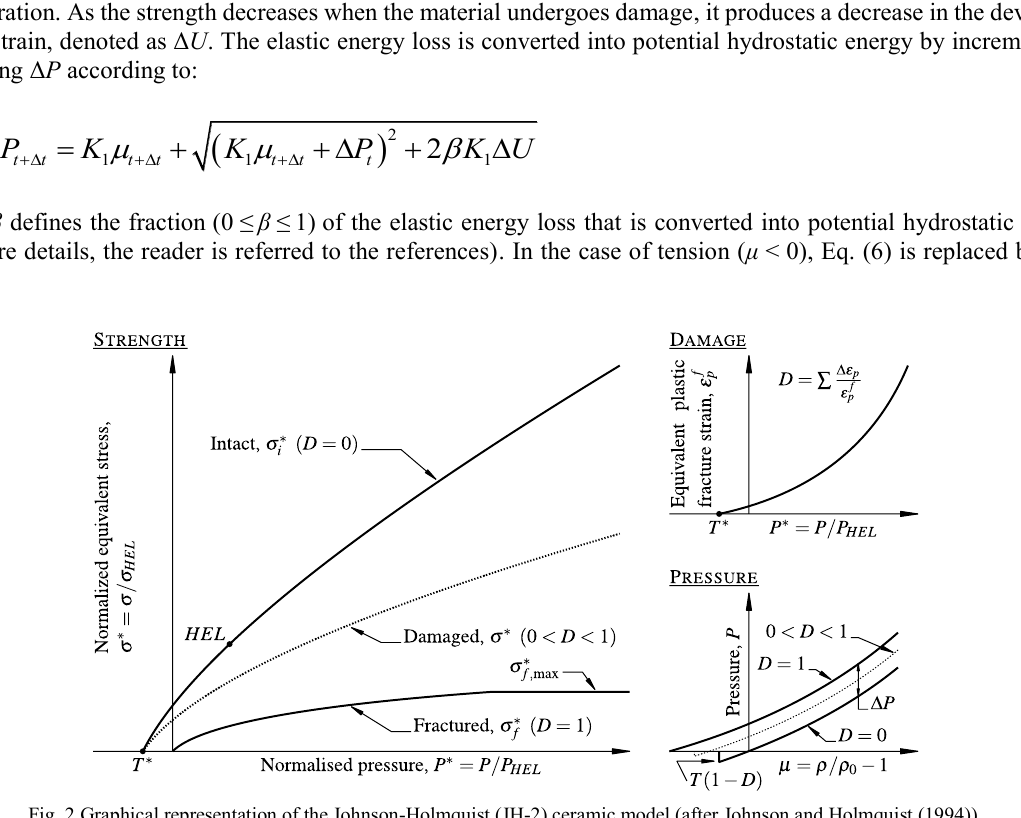
Fig. 2 Graphical representation of the Johnson-Holmquist (JH-2) ceramic model (after Johnson and Holmquist (1994)).